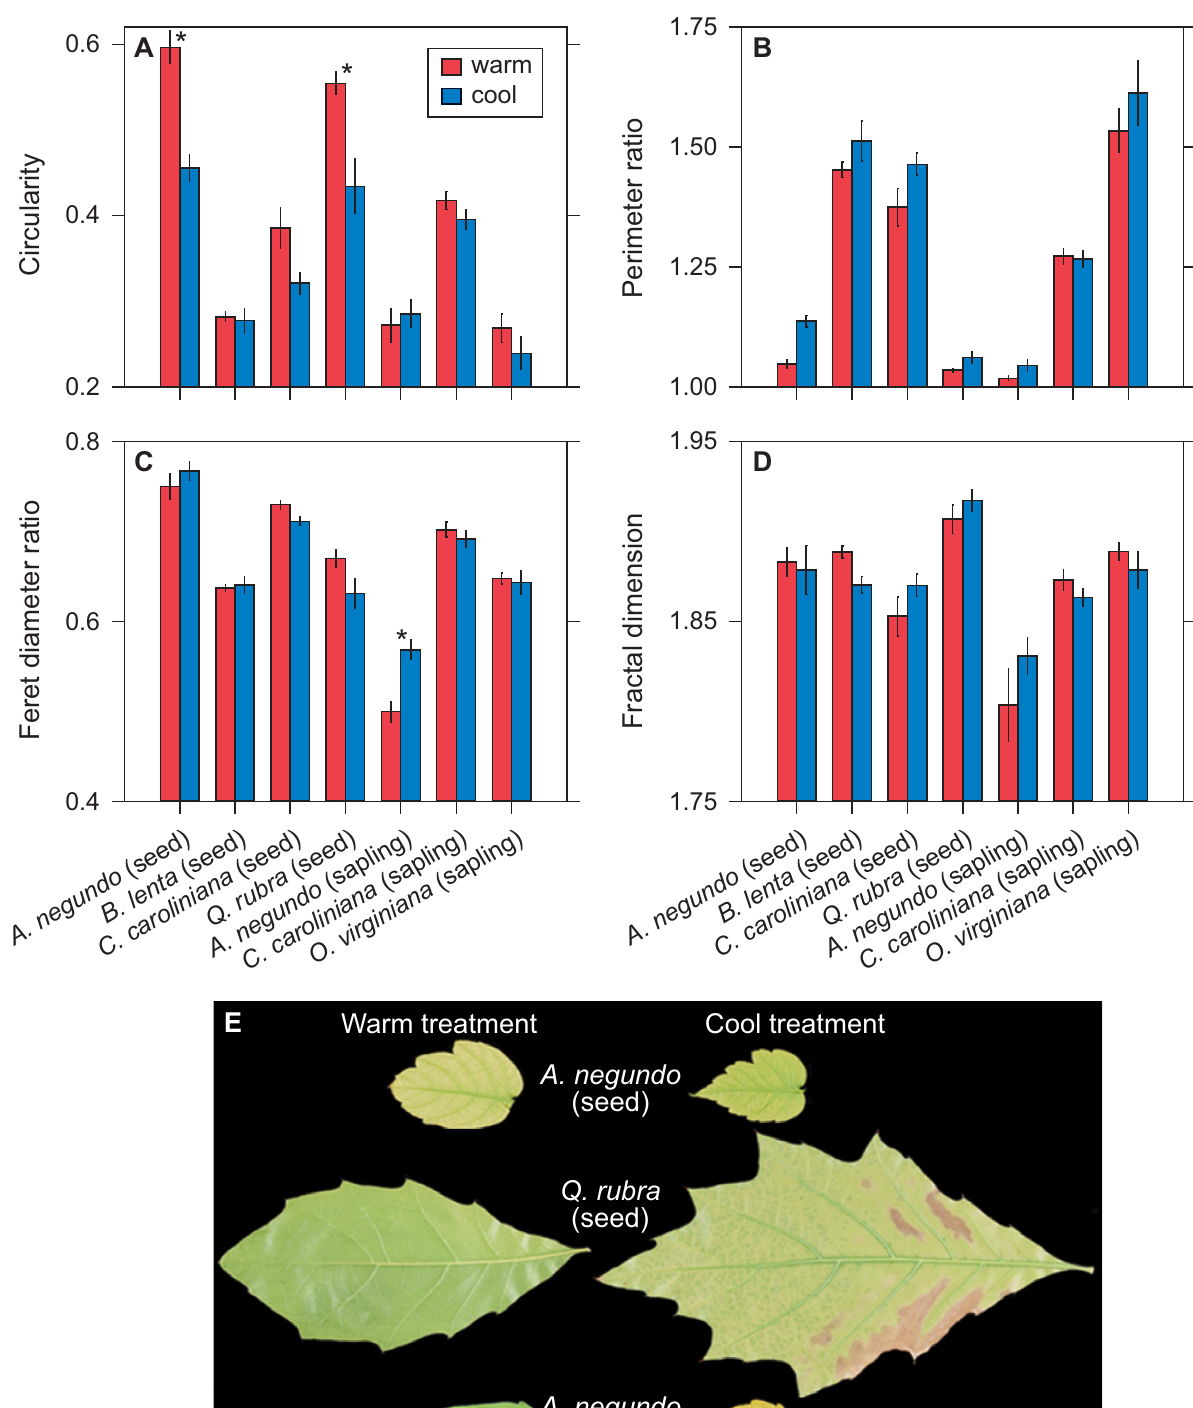
Fig 3. Sensitivity of leaf dissection variables to temperature. (A-D) Comparisons of the species grown in the growth cabinet experiment for leaf dissection variables. Values are means ± 1 s.e.m. � indicates a significant difference ( P < 0.05) based on estimated marginal means (see Materials and Methods). Global site-based patterns [6] would predict higher values in the cool treatment for perimeter ratio, feret diameter ratio, and fractal dimension; and lower values for circularity. (E) Representative leaves from species in this experiment that show significant differences in leaf dissection between the two treatments. Scale bar = 1